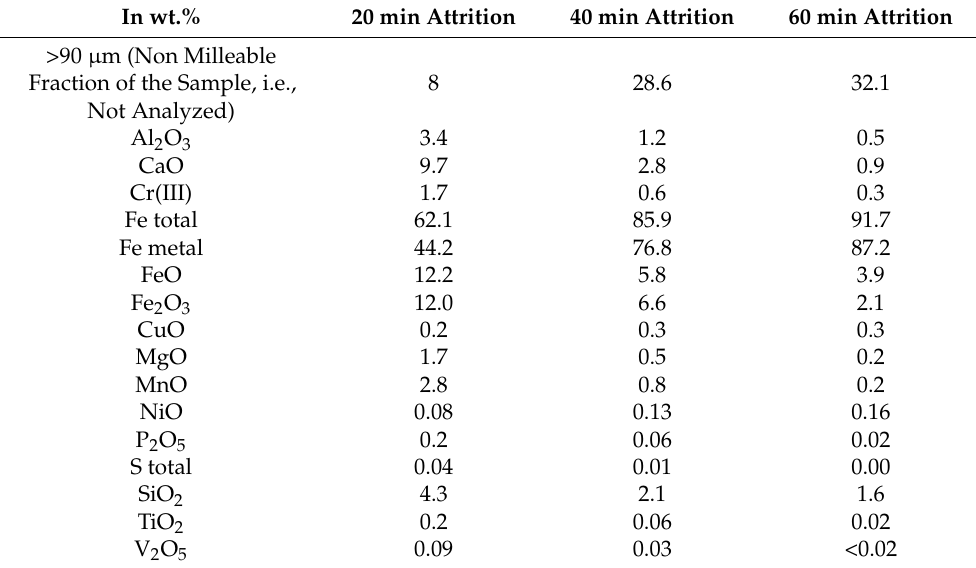
Table 6. Detailed composition of the size fraction +1–2 mm (Fe-rich particles) obtained after several attrition durations on the magnetic fraction (analyzed according to DIN EN 13656). In wt.% 20 min Attrition 40 min Attrition 60 min